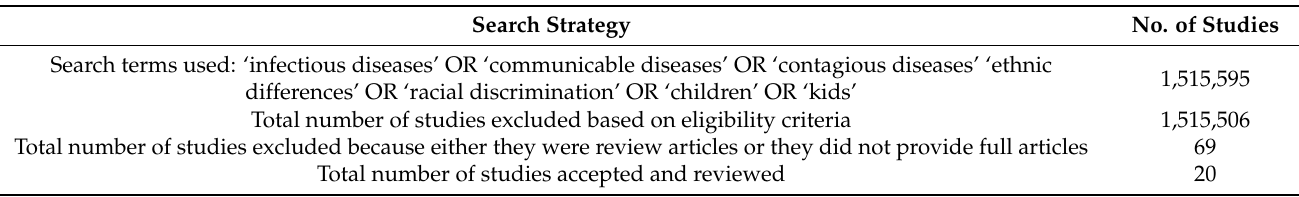
Table 2. Research thread for all